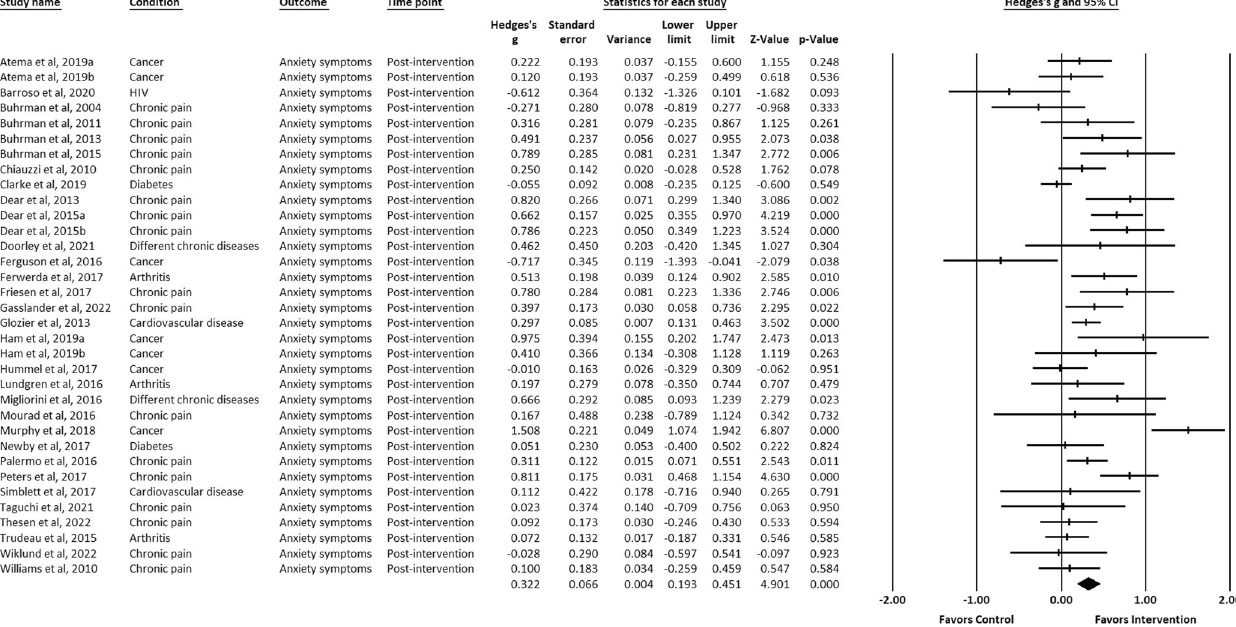
Fig. 3 Forest plot for effect sizes of IM-CBT on anxiety symptoms at